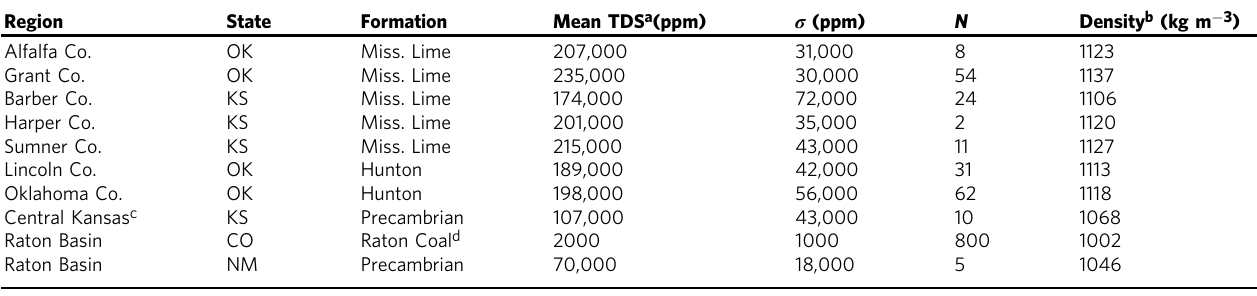
Table 1 Composition of water produced from Mississippi Lime, Hunton, and Precambrian (basement) formations in select counties of Oklahoma and Kansas